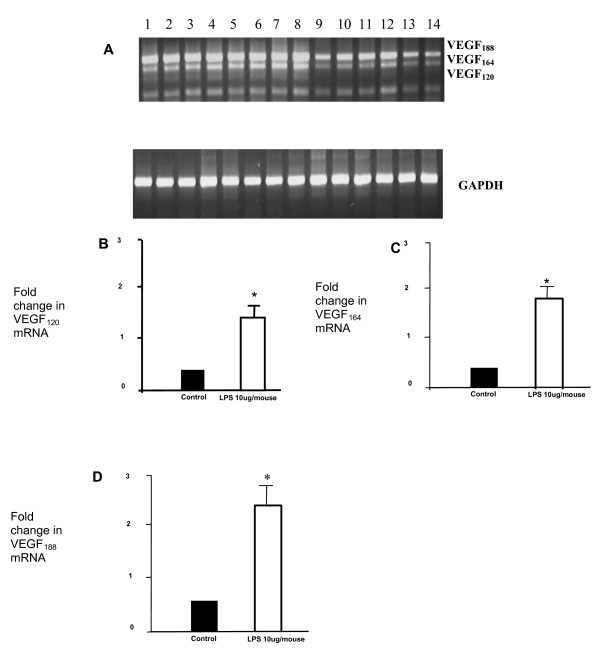
4 samples were examined for each treatment group. A) Representative RT-PCR gel of VEGF isoforms in control and injured murine lung. Lanes are as follows: (1–8) injured murine lung at day 5 (24 hours post last LPS dose) (9–12) injured murine lung at day 2 (24 hours post last LPS dose), (13–14) control murine lung. B-D): Further real-time PCR analysis was undertaken in the samples at day 5. This confirmed the increased levels of VEGF120, VEGF164 and VEGF188 in injured murine lung (*p < 0.05 fold change compared to control).